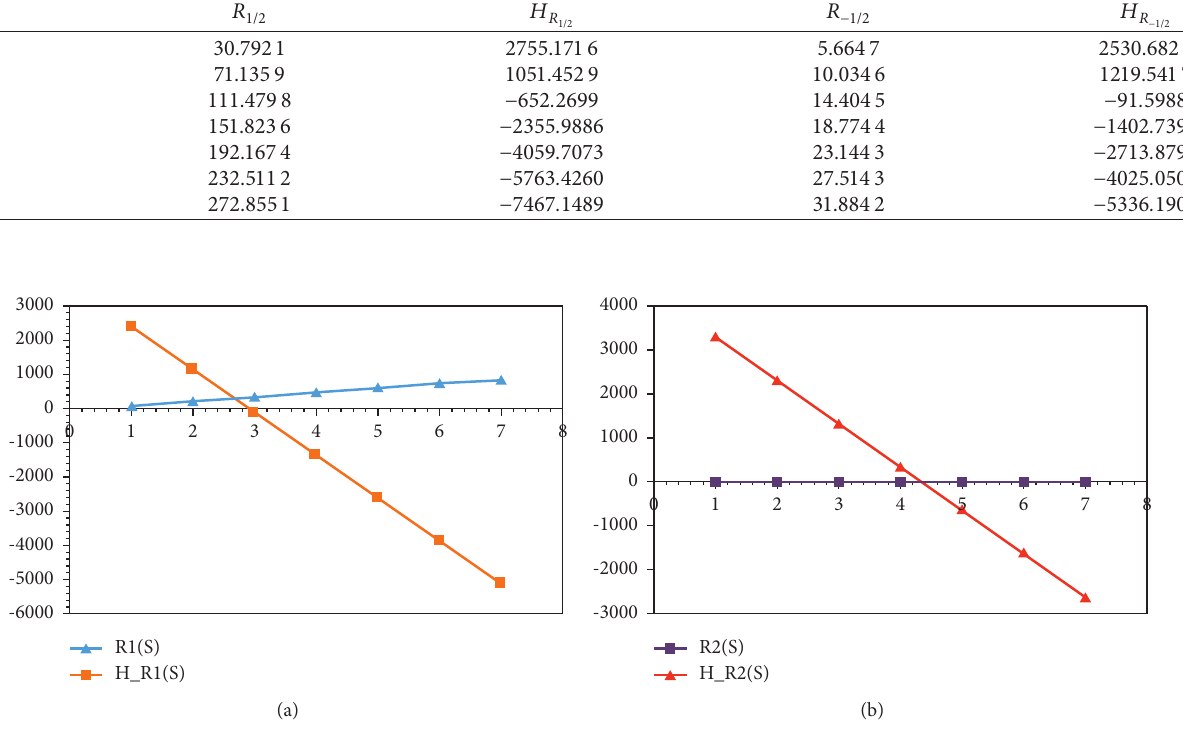
Figure 3: (a) Comparison of Randi c index for α � 1 with heat of formation. (b) Comparison of Randi c index for α � − 1 with heat of formation.